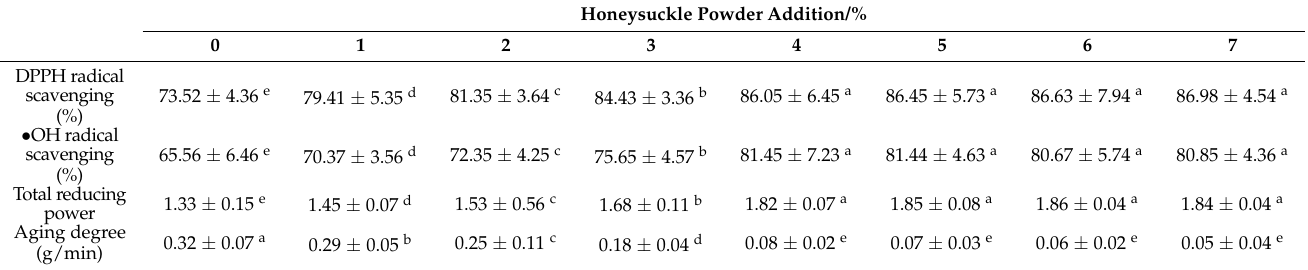
Table 4. The effects of the addition of honeysuckle powder on the antioxidant and antiaging capacities of the bread. Honeysuckle Powder